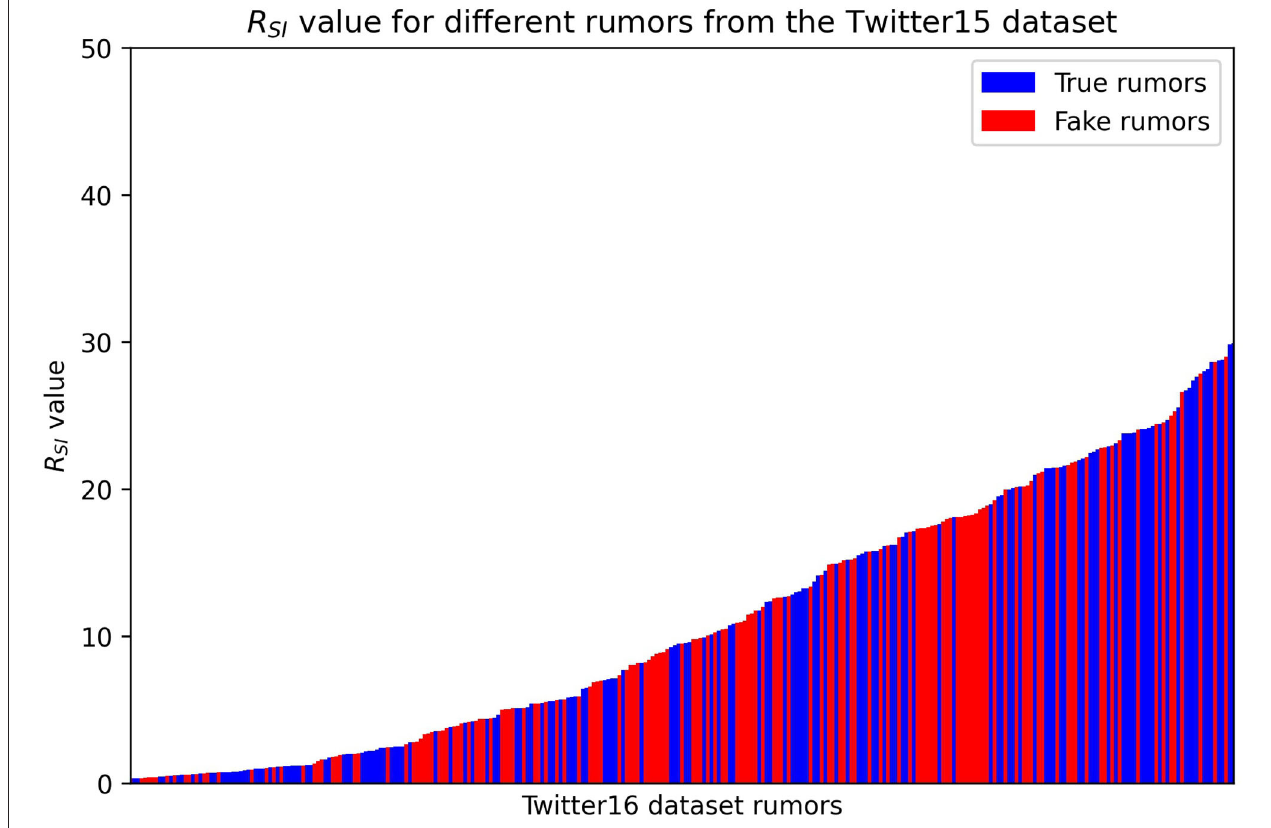
FIGURE 4 | RSI values of different rumors. Red = False rumors, Blue = True